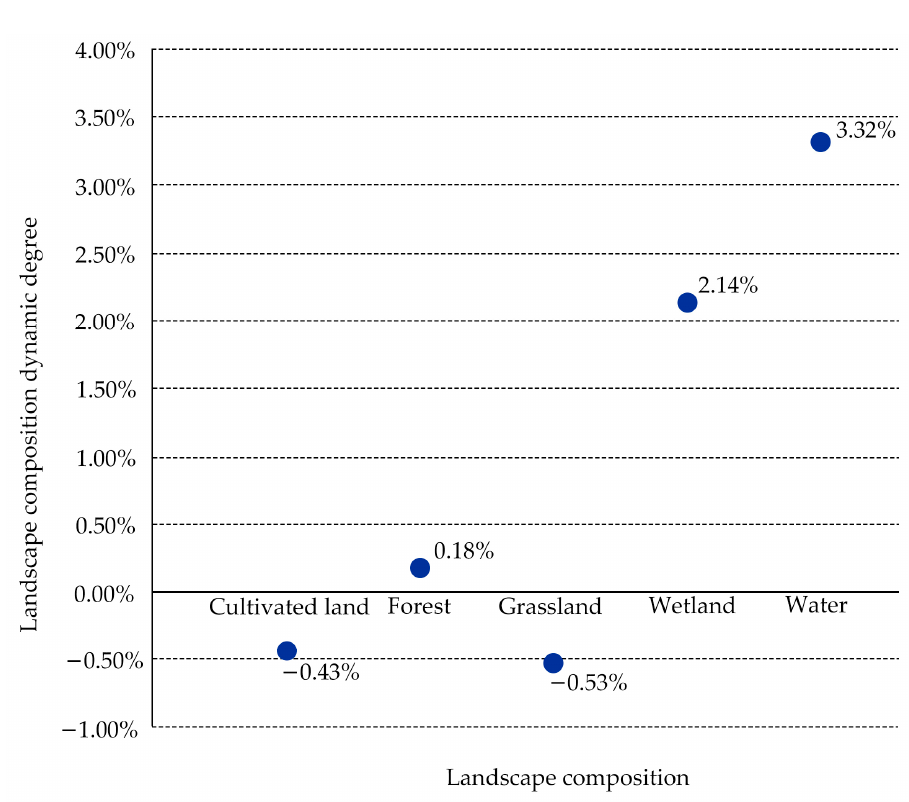
Figure 4. The proportion of green space coverage in 2010 and 2020.